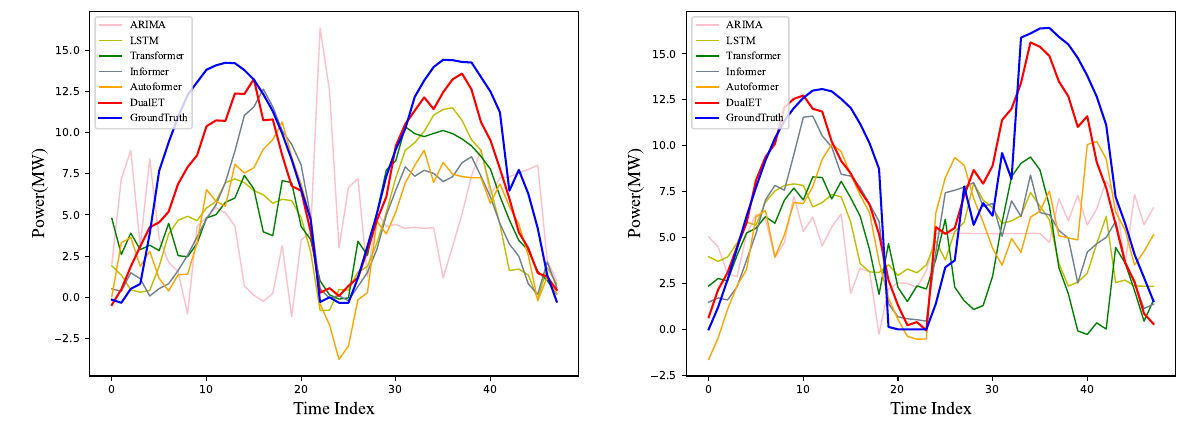
Figure 4. Prediction results of different models.